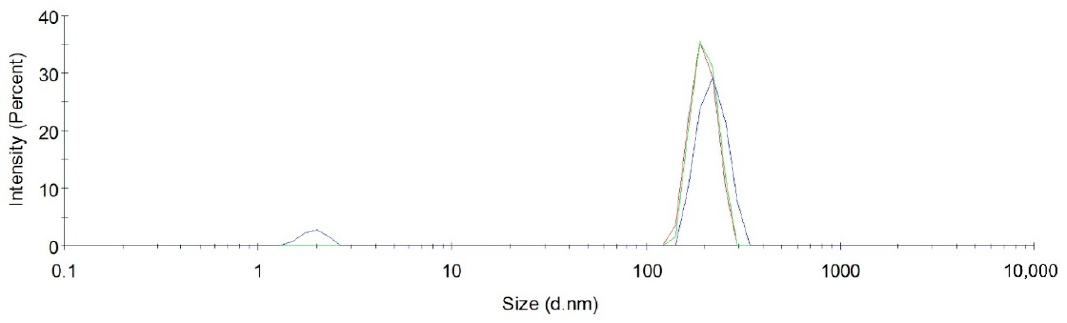
Figure 11. Intensity ‐ weighted PSD of calixarene 3 in CHCl 3 /MeOH = 1:1 ( C = 0.2 mg/mL).